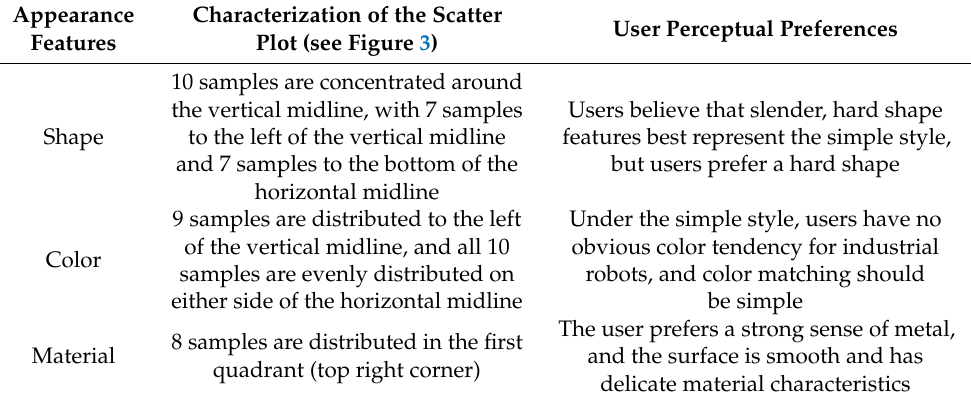
Figure 3. Distribution of the 10 sample images on the perceptual vocabulary group: ( a ) Sample distribution of shape features; ( b ) Sample distribution of color features; ( c ) Sample distribution of material features. Table 3. User preference characteristics for the industrial robot’s appearance in a simple